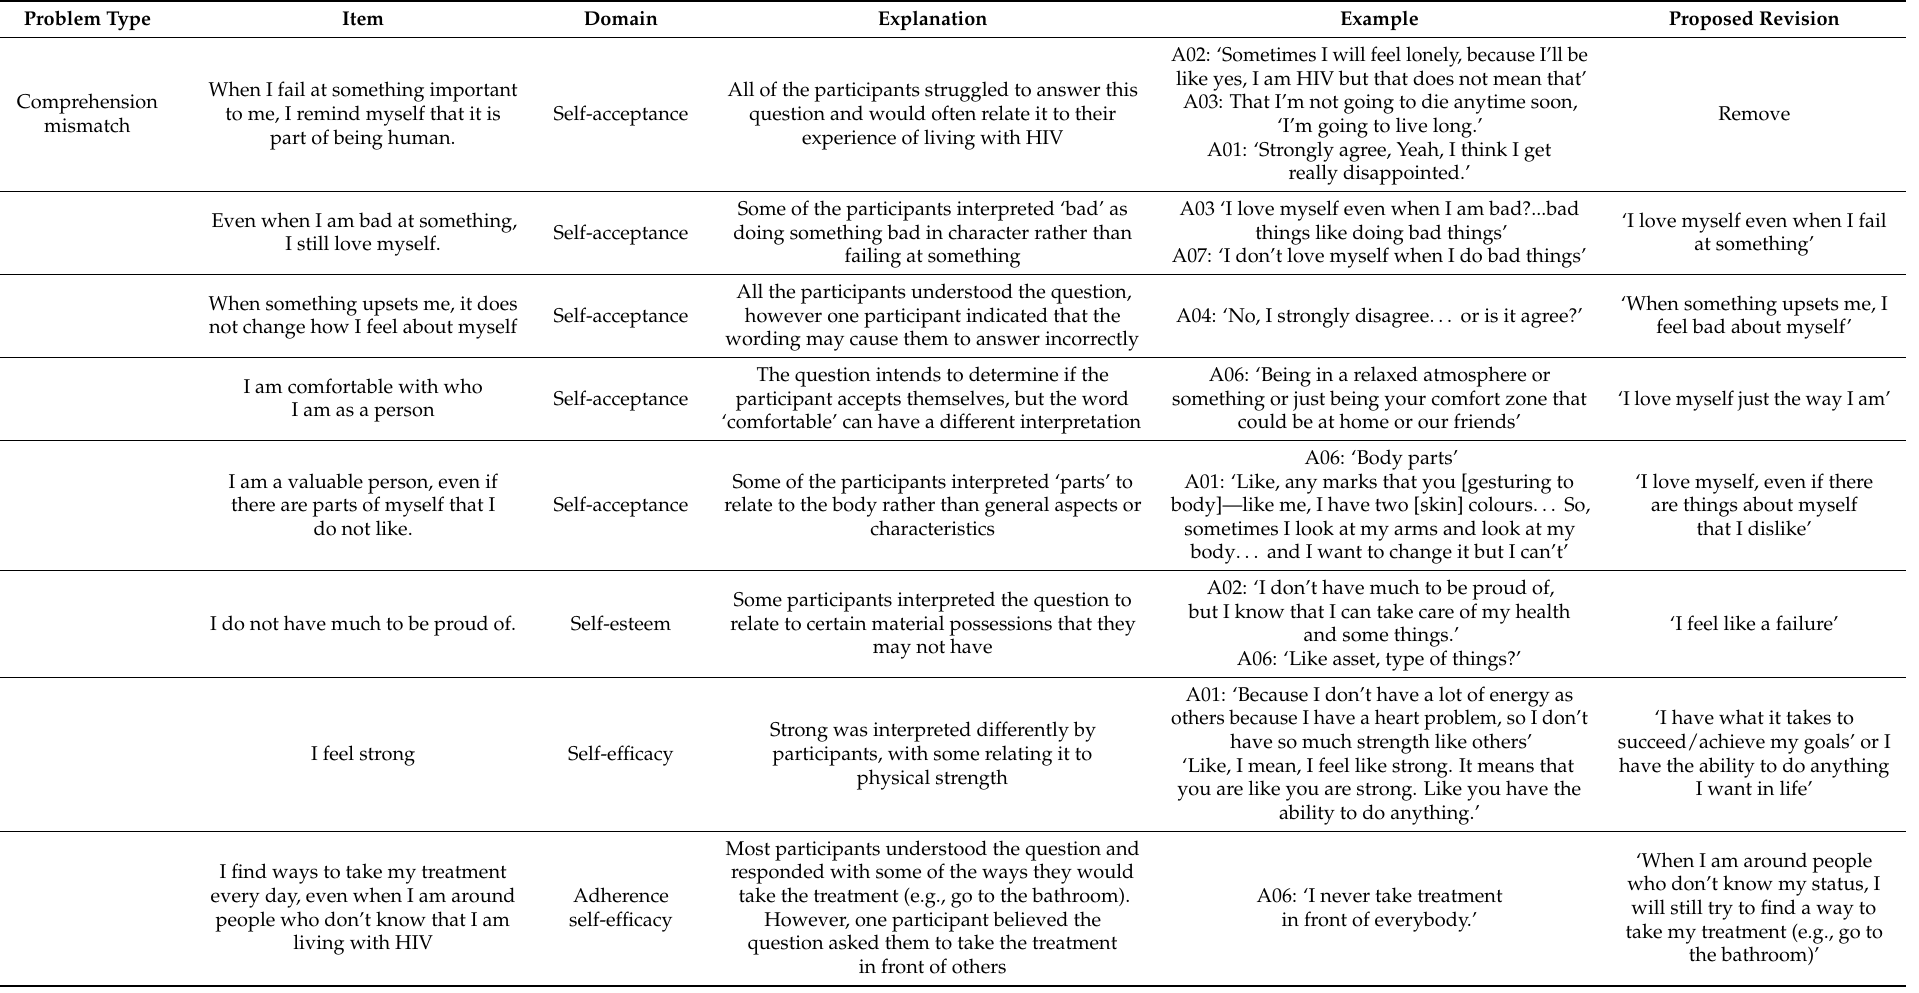
Table 3. Summary of Problem Types and Proposed